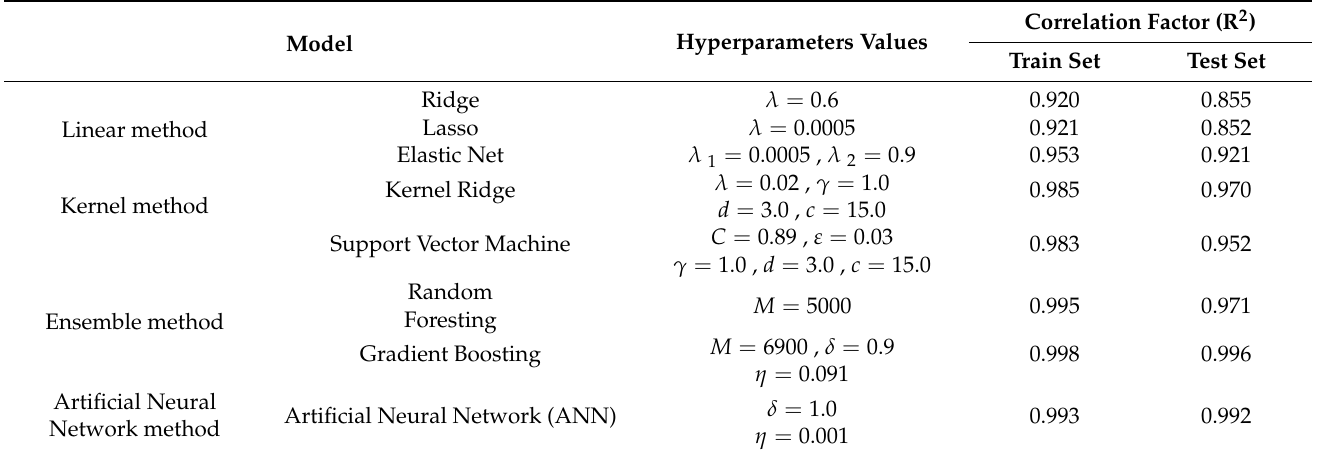
Table 5. Machine learning models’ optimized hyperparameters and accuracy.